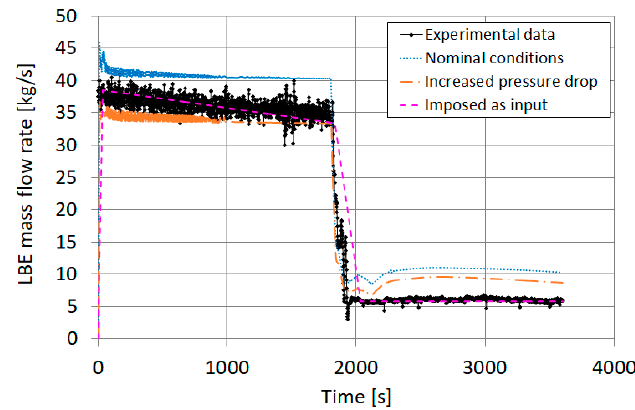
Figure 6. LBE mass flow rate. Comparison between experimental data and numerical results obtained under different conditions.